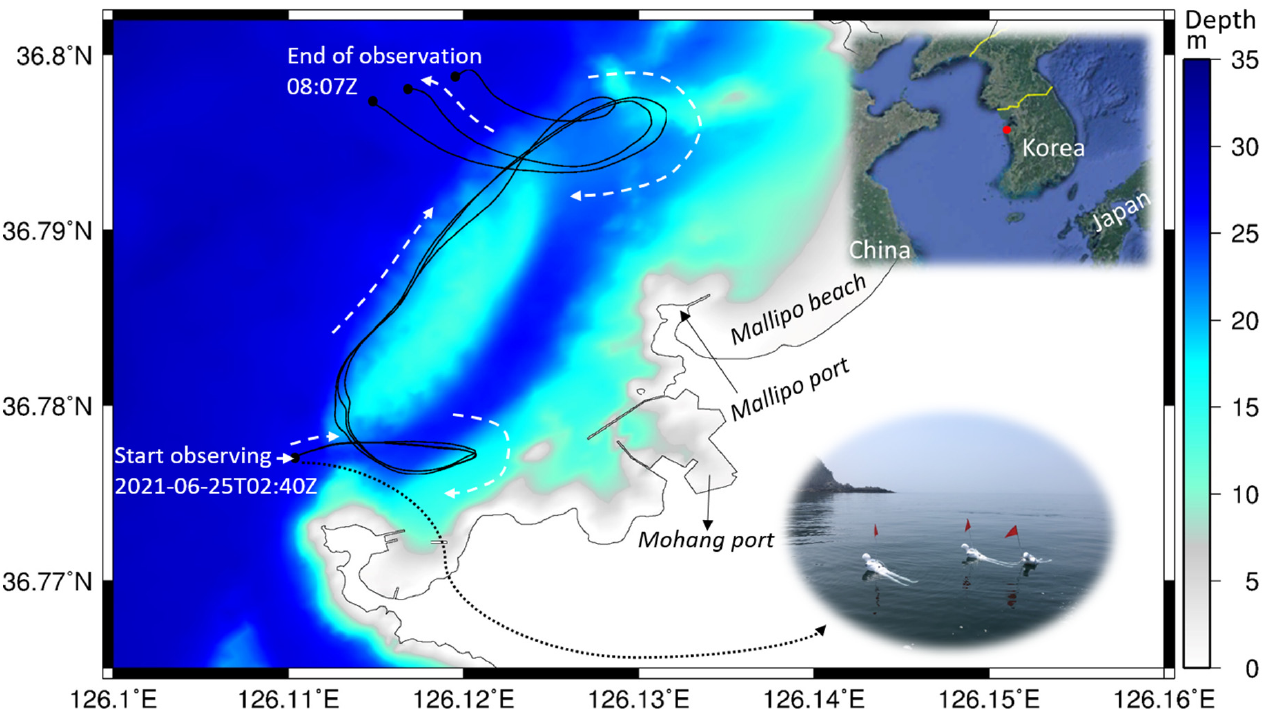
Figure 4. Map showing in situ mannequin drogue experiment near a beach in